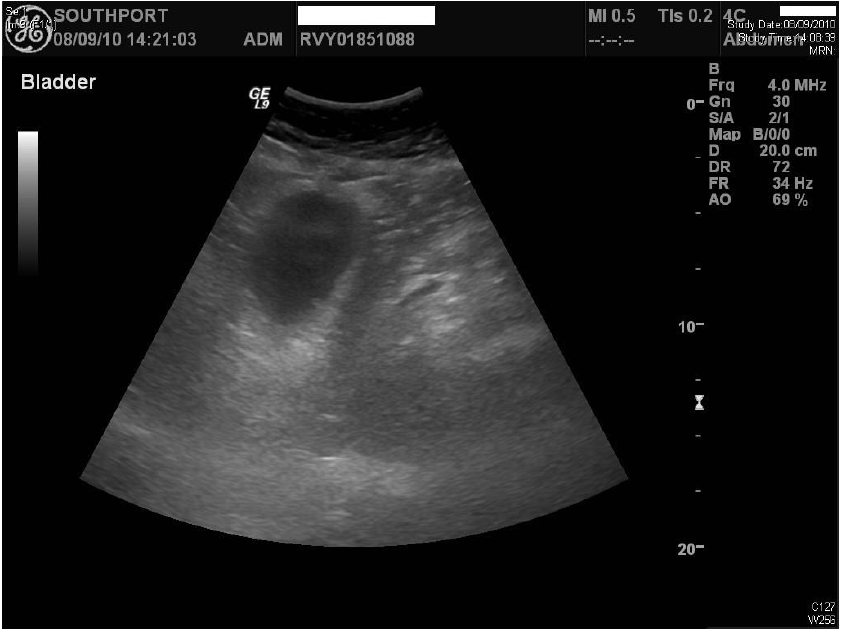
FIGURE 1. Ultrasound image of the urinary bladder, performed on 08 September 2010, showed no calculi; bladder was